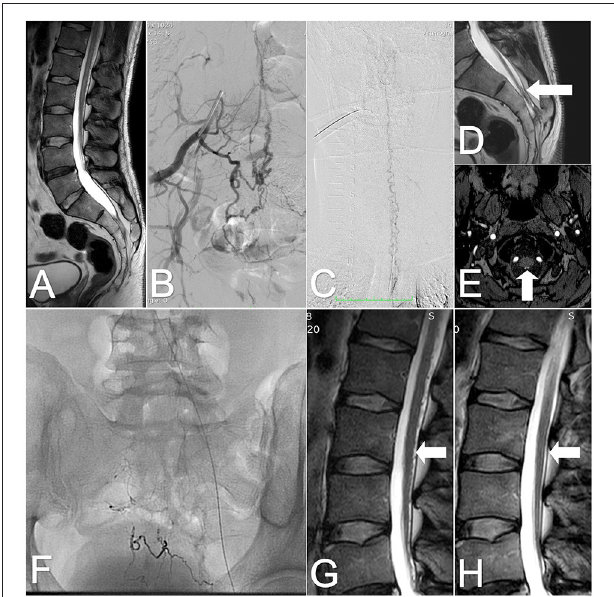
FIGURE 2 | Images of the spinal cord of case 2, before and after treatment. ( A) T2-weighted MRI: Tethered cord and sacral lipoma. (B) DSA: SDAVF at the S2-S3 level supplied by the lateral sacral arteries. (C) DSA: Tortuous veins on the posterior surface of the cervical spinal cord. (D) T2-weighted MRI: Tortuous vein on the posterior surface of the tethered spinal cord (arrow). (E) TOF MRI: Draining vein (arrow) at the atlanto–occipital junction level. (F) X-ray of the sacral area shows embolic agents after three embolizations. (G) Lumbar T2-weighted MRI: After the last embolization, tortuous vessels are visible on the posterior surface of the spinal cord (arrow). (H) Follow-up MRI: at 6 months after the surgery, the tortuous veins are no longer observed on the posterior surface of the spinal cord